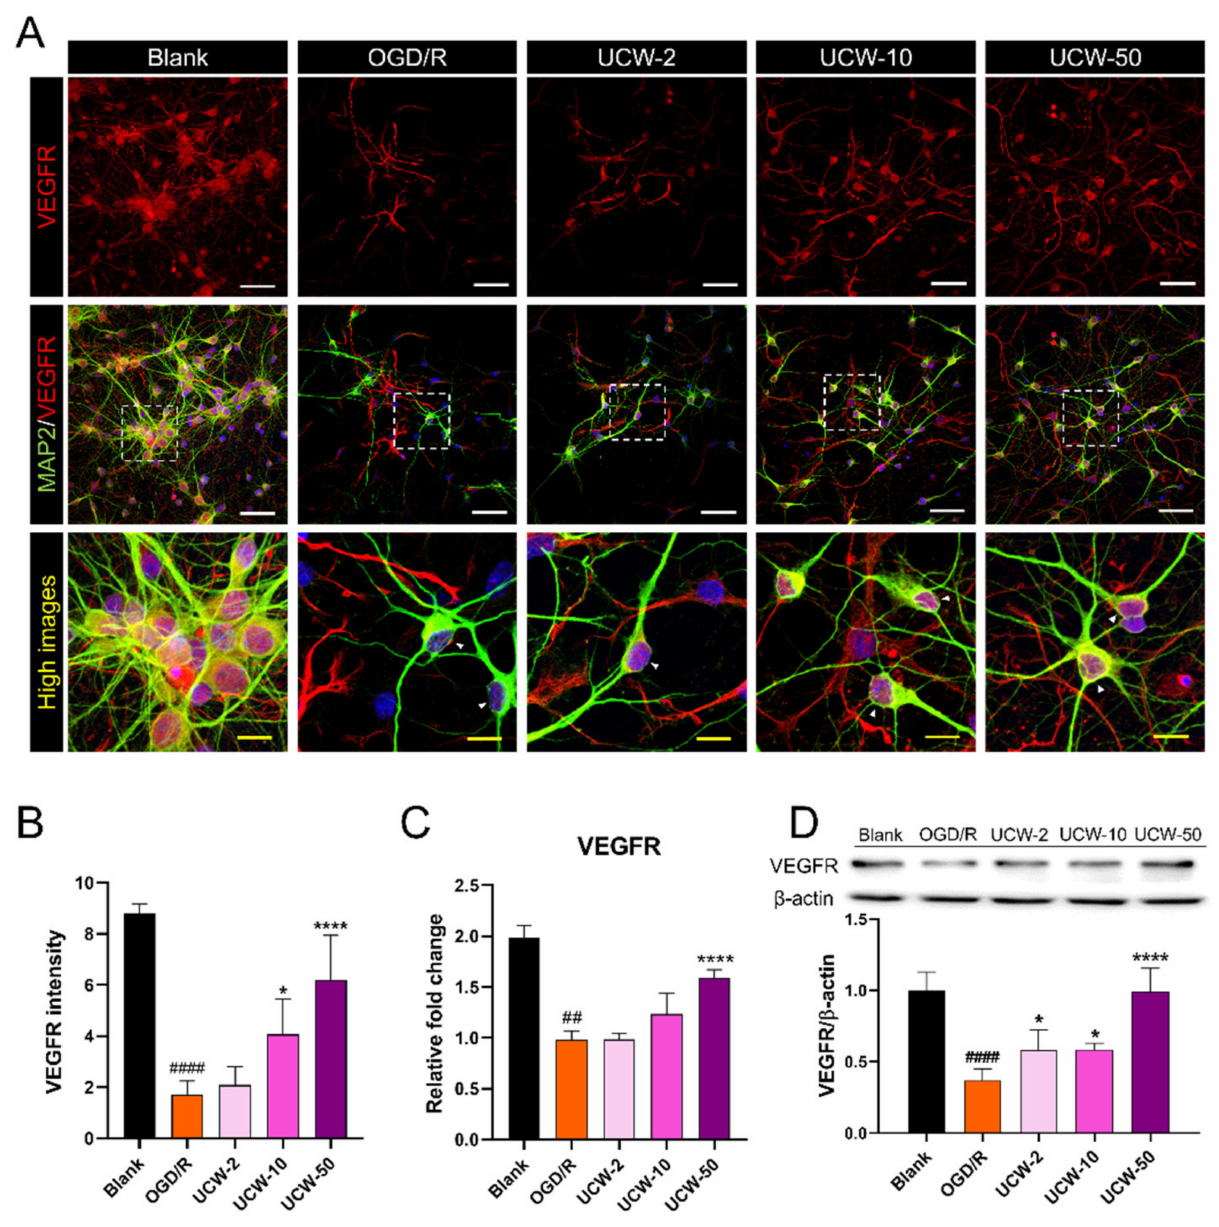
Figure 3. Angiogenic potential of UCW for OGD/R-induced hypoxic injury through enhancement of VEGF-VEGFR signaling. ( A ) Representative images of immunocytochemistry for MAP2 (green) and VEGFR (red) in blank, OGD/R injury, UCW + OGD/R injury. White scale bar = 50 µ m, yellow scale bar = 10 µ m. ( B ) Quantitative analysis of the relative VEGFR intensity in each group ( n = 8). ( C ) The relative gene expression levels for VEGFR mRNA using real-time PCR in each group ( n = 4). ( D ) Relative quantification of the VEGFR protein expression using Western blotting in each group ( n = 4). Data are expressed as the mean ± SEM. Significant differences were analyzed via ordinary ANOVA with Tukey’s post-hoc analysis as follows: ## p < 0.01 and #### p < 0.0001 vs. blank group; * p < 0.05 and **** p < 0.0001 vs. the OGD/R